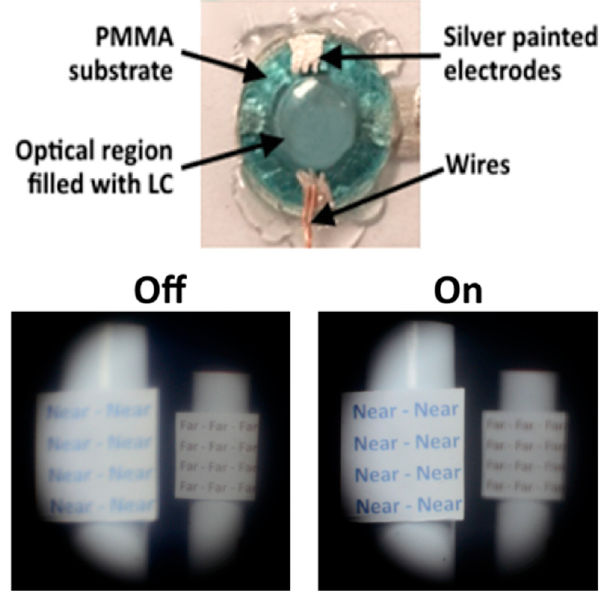
Figure 9. Example of a contact lens formed in PMMA that uses a convex solid geometry based on homeotropic homogeneous alignment [38]. Shown below are the 0 V and 7 V rms images taken through the contact lens for objects at 5 cm and 15 cm distances. In this example, a positive meniscus lens with the geometry of Figure 6a has been used, so that applying the field causes a +2D optical change as required for the presybope. The focal distances used here do not represent what the eye would see, since much of the focusing is still done by the presbyopic lens.